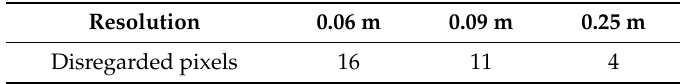
Table 11. The disregarded pixels corresponding to 1 m in different resolutions.